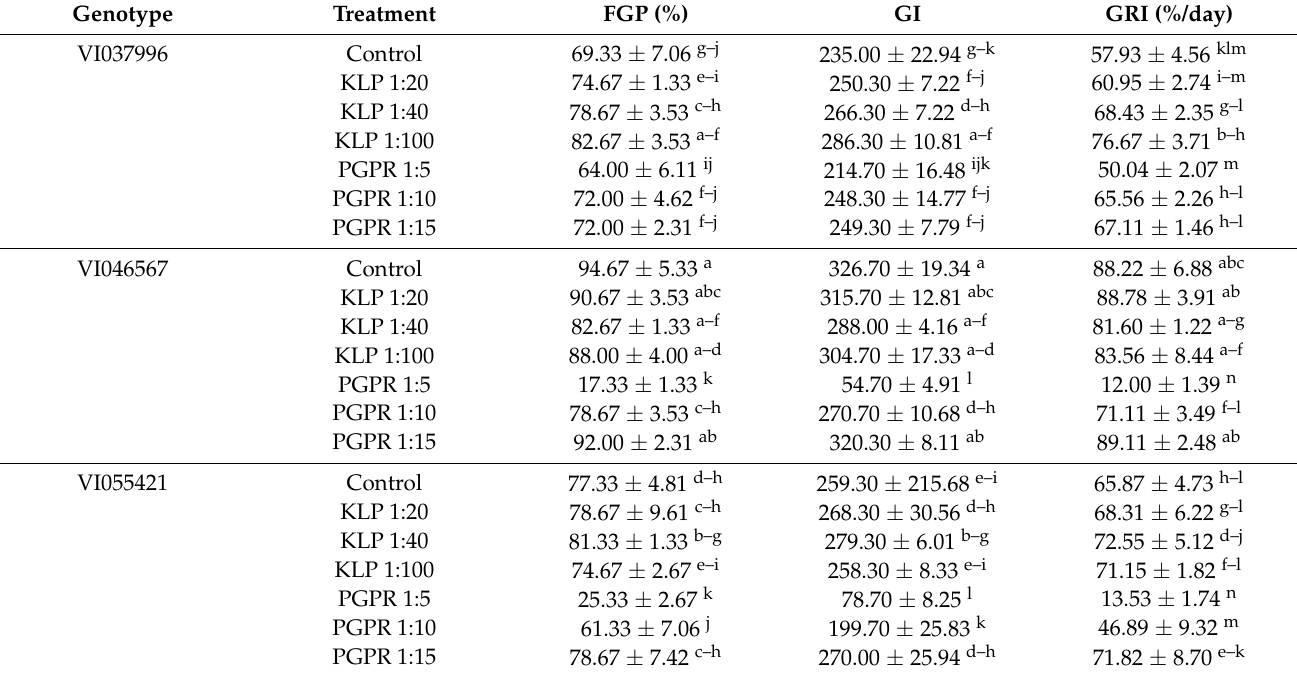
Figure 4. Effect of genotypes on time spread of Abelmoschus esculentus seed germination. Bars representing mean values and standard errors with different letters indicate statistically significant ( p ≤ 0.05) differences based on Fisher’s protected least significant difference test (Genstat 64-bit Release 18.2). Table 3. Interaction effect of Abelmoschus esculentus genotypes and biostimulant (KLP, Kelpak ® ; PGPR, plant-growth- promoting rhizobacteria) treatments. FGP, final germination percentage; GI, germination index; GRI, germination rate index. In each column, mean values ( ± standard errors) followed by different letters indicate statistically significant ( p ≤ 0.05)